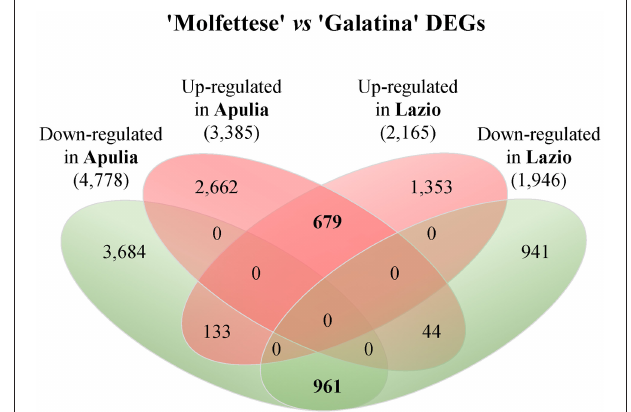
FIGURE 3 | Number of DEGs between Mol and Gal grown in Apulia and Lazio. The numbers of up- (red bordered ellipsis) or down-regulated (green bordered ellipsis) DEGs in Mol with respect to Gal in both locations are reported. The number of DEGs with common or opposite expression trends are shown in the overlapping ellipsis areas. A total of 1640 (961 down-regulated plus 679 up-regulated) transcripts showed similar expression differences independently of the cultivation zone (bolded